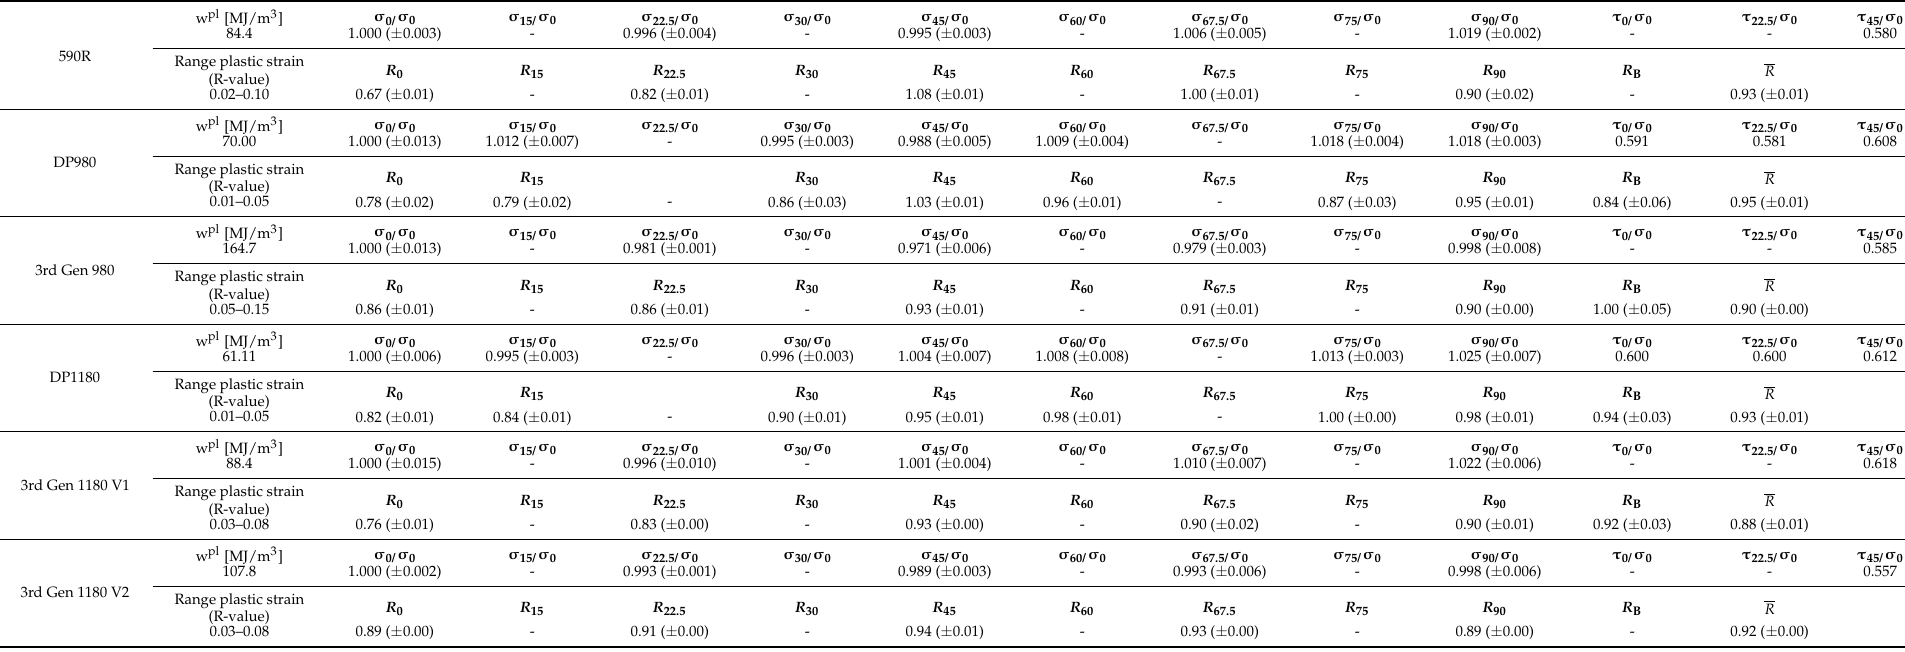
Table 5. R-value and stress ratios of the studied 3rd Gen AHSS grades. Note that R refers to the normal